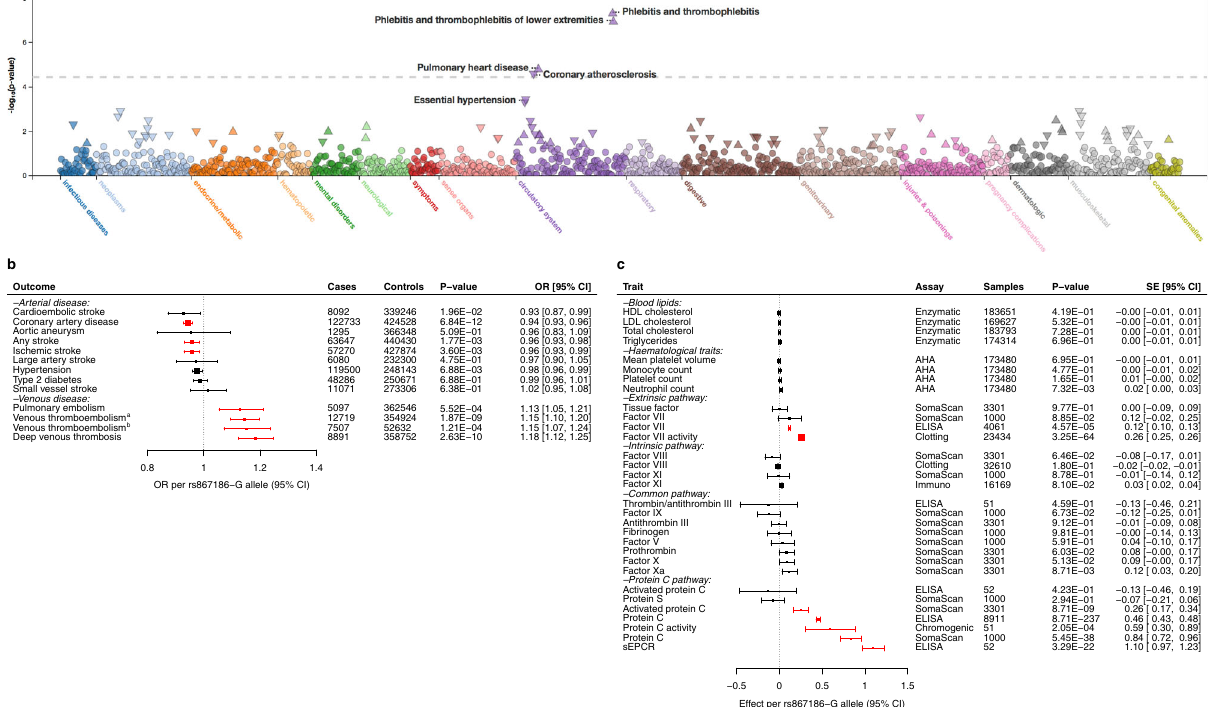
Fig. 2 Association of PROCR -219Gly with a range of health outcomes and circulating cardiovascular biomarkers. a Phenome-wide association scan of PROCR -p.S219G (rs867186) across 1402 broad electronic health record-derived ICD-codes from the UK Biobank. Unadjusted P values were obtained from the PheWeb portal. b Forest plot showing the associations of the minor (G) allele of rs867186 genotype with different cardiovascular conditions. Association statistics for VTE outcomes were obtained from the INVENT consortium (a) or UK Biobank (b). Data are presented as odds ratios with 95% con fi dence intervals (horizontal lines). Box sizes are proportional to inverse-variance weights. For each phenotypic subgroup, associations are ordered by their effect size. P values were obtained from the published GWAS. Associations that passed correction for multiple testing in this analysis ( P = 0.05/13 traits = 3.85 × 10 − 3 ) are highlighted in red. The number of cases and controls for each association is shown in the forest plot. Supplementary Data 1 provides the association statistics for all traits, as well as data sources and references. c Forest plot showing the associations of rs867186-G with clinical biomarkers (blood lipids, hematological traits) and plasma proteins of the coagulation cascade (extrinsic, intrinsic and common pathways) and protein C pathways. Data are presented as per-allele changes in the traits expressed as standard deviations with 95% con fi dence intervals (horizontal lines). Box sizes are proportional to inverse-variance weights. For each phenotypic subgroup, associations are ordered by their effect size. P values were obtained from the published GWAS. Associations that passed correction for multiple testing in this analysis ( P = 0.05/31 traits = 1.61 × 10 − 3 ) are highlighted in red. The number of participants for each association is shown in the forest plot. Supplementary Data 1 provides the association statistics for all traits, as well as